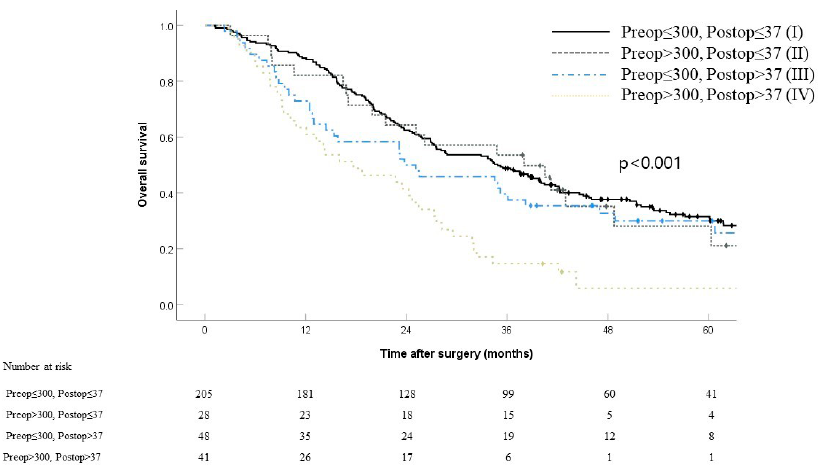
Figure 2. Kaplan–Meier curves comparing overall survival stratified by preoperative and postoperative CA19-9 levels (I: preop ≤ 300, postop ≤ 37, II: preop > 300, postop ≤ 37, III: preop ≤ 300, postop > 37, IV: preop > 300, postop > 37). p = 0.720 (I vs. II), p = 0.205 (I vs. III), p < 0.001(I vs. IV), p = 0.643 (II vs. III), p = 0.003 (II vs. IV), p = 0.009 (III vs. IV).